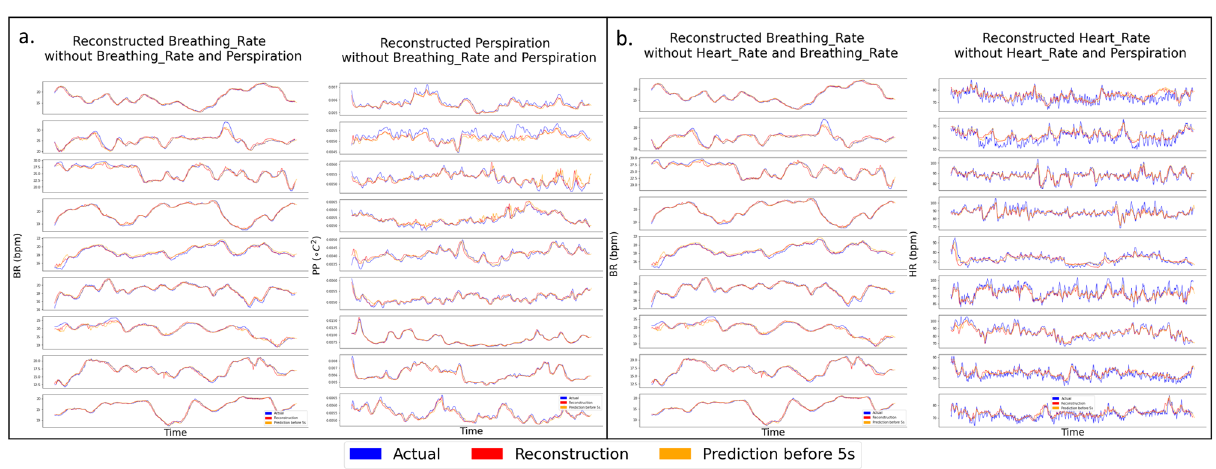
Figure 4. Estimations for missing modalities (2 missing modalities at the same time) based on other modalities for all nine testing sessions. ( a ) Masking breathing rate and perspiration, ( b ) masking heart rate and breathing